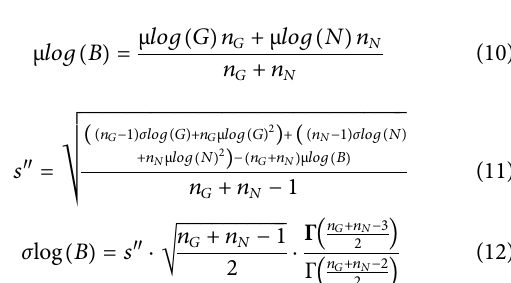
Frontiers in Built Environment |